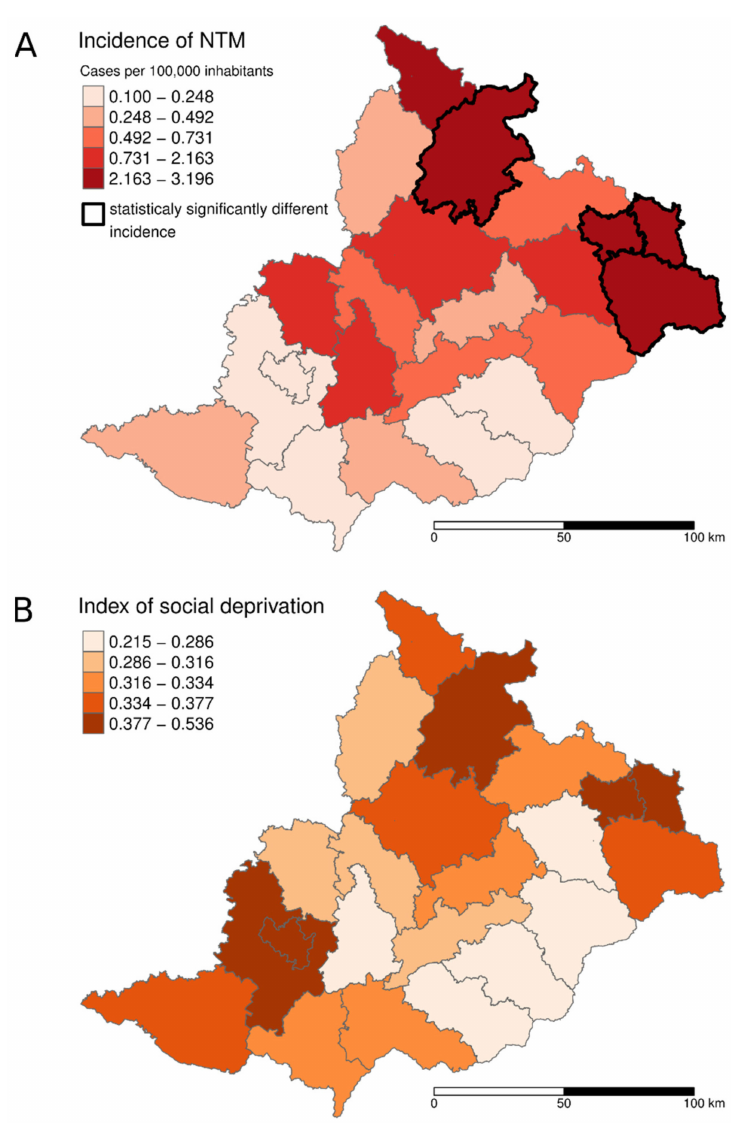
Figure 3. ( A ) Average incidence of NTM pulmonary diseases; ( B ) Index of social deprivation in the districts of the studied area during the period